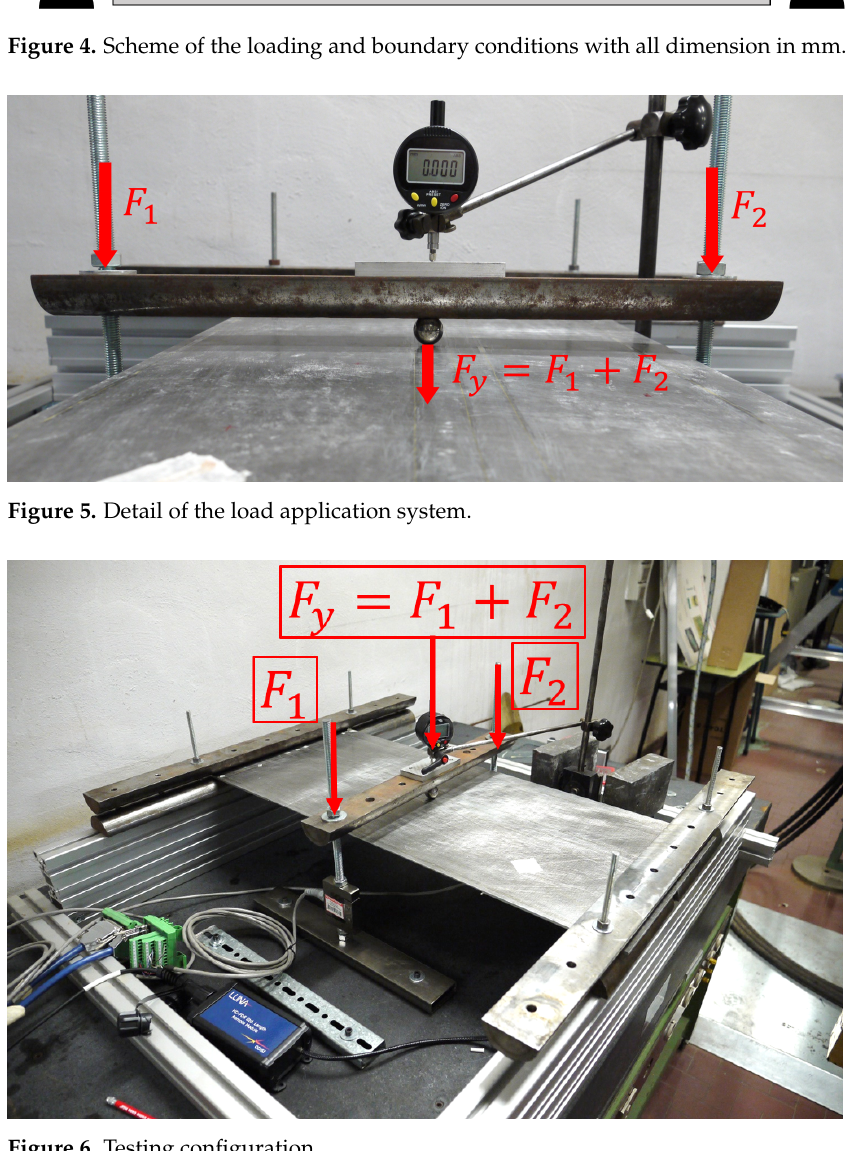
Figure 6. Testing